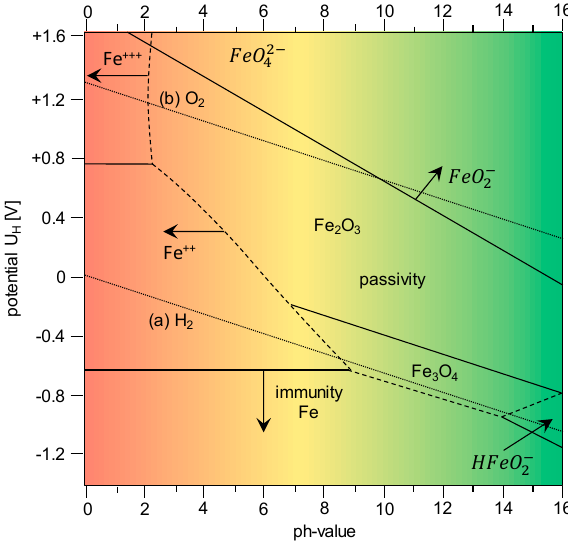
Figure 1. Potential pH diagram for iron based on [10,11].